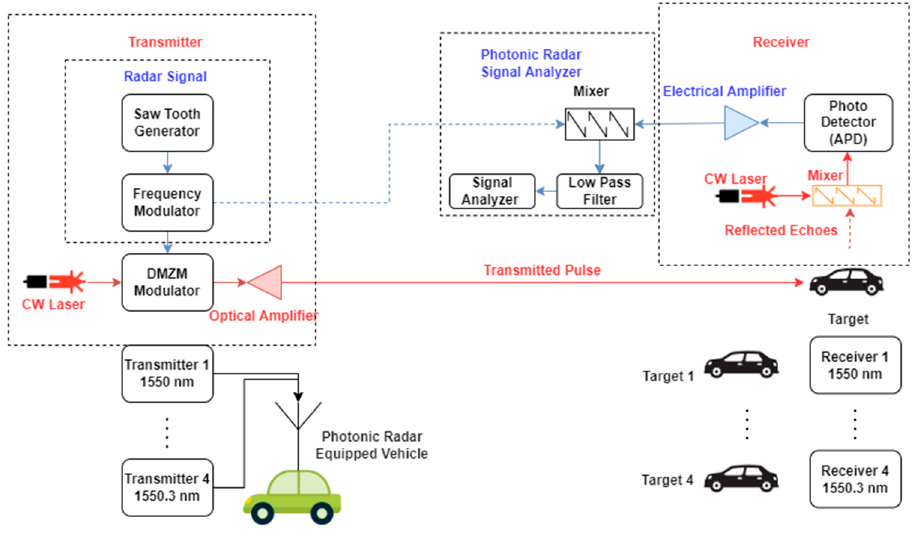
Figure 1. Schematic representation of proposed 77 GHz Photonic radar for multiple target (four) detection.